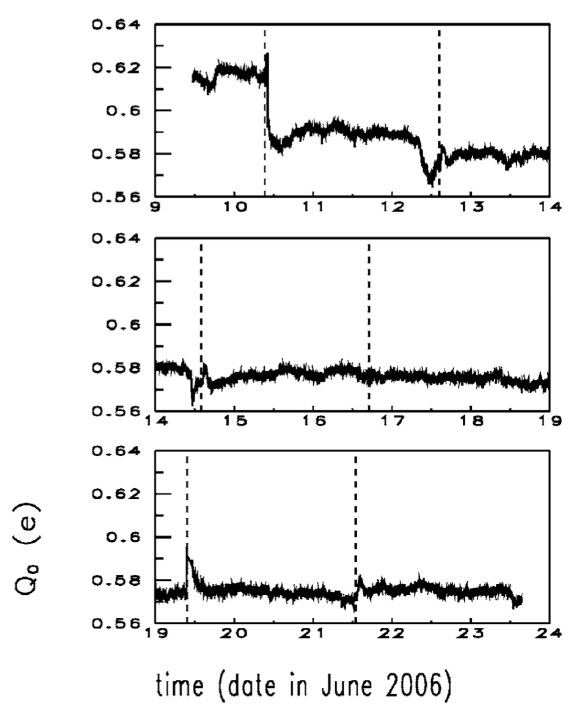
Figure 7. Charge offset drift measured in an Si/SiO 2 device with electrostatic barriers where the temperature was held constant between 20 to 40 mK. In general, very small drift is observed. Vertical dashed lines represent helium transfers and mechanical disturbances of the system where some change in Q 0 is seen. Note the y -scale is quite magnified. Reproduced with permission from reference [45], Copyright 2007, American Institute of